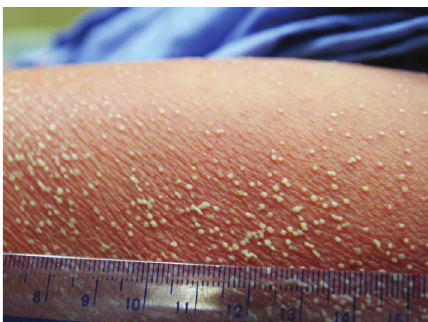
Figure 2: Nonfollicular, pinpoint, and superficial pustules on an erythematous